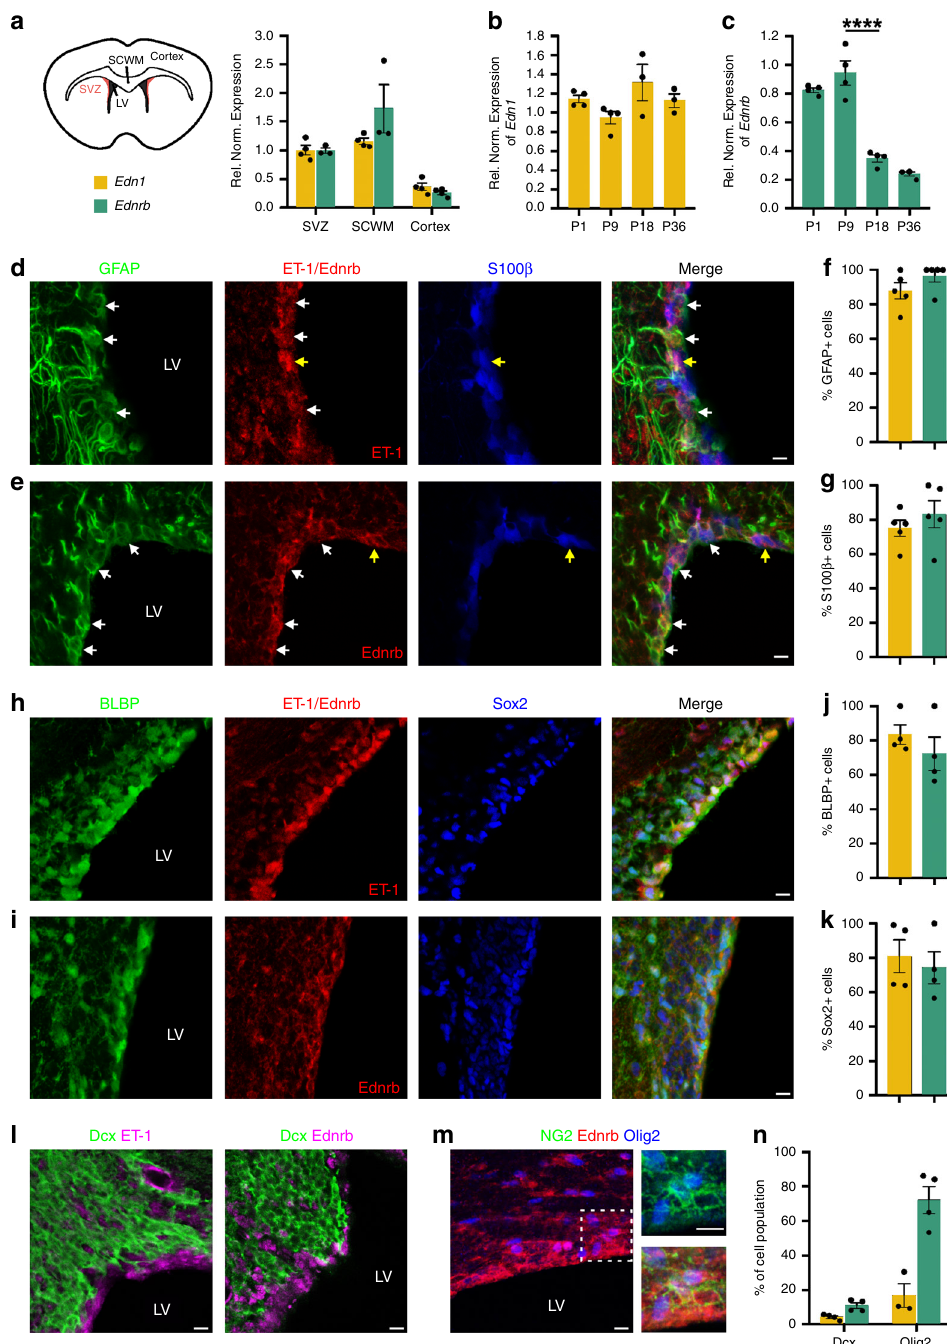
Fig. 1 ET-1 and Ednrb are expressed in the developing postnatal SVZ. a QPCR for Edn1 and Ednrb mRNA levels in different regions of the postnatal day 7 (P7) mouse brain. SCWM and cortex values were compared with SVZ expression values, which were normalized to 1. ( Edn1: n = 4 mice for each region, Ednrb: n = 3 mice for SVZ and SCWM, 4 mice for Cortex). QPCR for Edn1 ( b ) and Ednrb ( c ) mRNA levels in the SVZ over the fi rst postnatal month ( n = 4 mice for each timepoint, except n = 3 for Edn1 P18 and P36 timepoints). **** p value < 0.0001 (one-way ANOVA with Tukey ’ s multiple comparisons test). P1, P18, and P36 values were compared with P9 expression values, which were normalized to 1. Both ET-1 ( d ) and Ednrb ( e ) protein co-localize with RGC markers GFAP and S100 β in the P10 mouse SVZ. White arrows point to ET-1 + or Ednrb + GFAP + cells. Yellow arrows point to ET-1 + or Ednrb + S100 β + cells. Quanti fi cation of the percentage of GFAP + cells ( f ) and S100 β + cells ( g ) in the dorsal WT SVZ at P10 that express ET-1 (yellow bar) or Ednrb (teal bar). ( n = 5 WT mice for ET-1 and Ednrb). Both ET-1 ( h ) and Ednrb ( i ) protein co-localized with RGC markers BLBP and Sox2. Quanti fi cation of the percentage of BLBP + cells ( j ) and Sox2 + cells ( k ) in the dorsal WT SVZ at P10 that express ET-1 or Ednrb. ( n = 4 WT mice for ET-1 and Ednrb). l Neither ET-1 nor Ednrb is expressed by Dcx + NPCs. m NG2 + Olig2 + OPCs in the SVZ and SCWM express Ednrb. n Quanti fi cation of the percentage of Dcx + cells and Olig2 + cells in the dorsal SVZ that express ET-1 or Ednrb at P10. ( n = 4 WT mice for ET-1 and Ednrb co-staining with Dcx, 3 WT mice for ET-1 co- staining with Olig2, and 4 WT mice for Ednrb co-staining with Olig2). All scale bars = 10 μ m. LV lateral ventricle. Data are presented as mean values ± SEM. Source data are provided as a Source Data fi